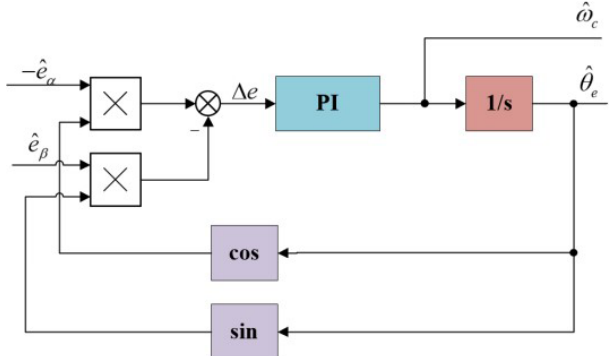
Figure 4. Establishment of the phase-locked loop